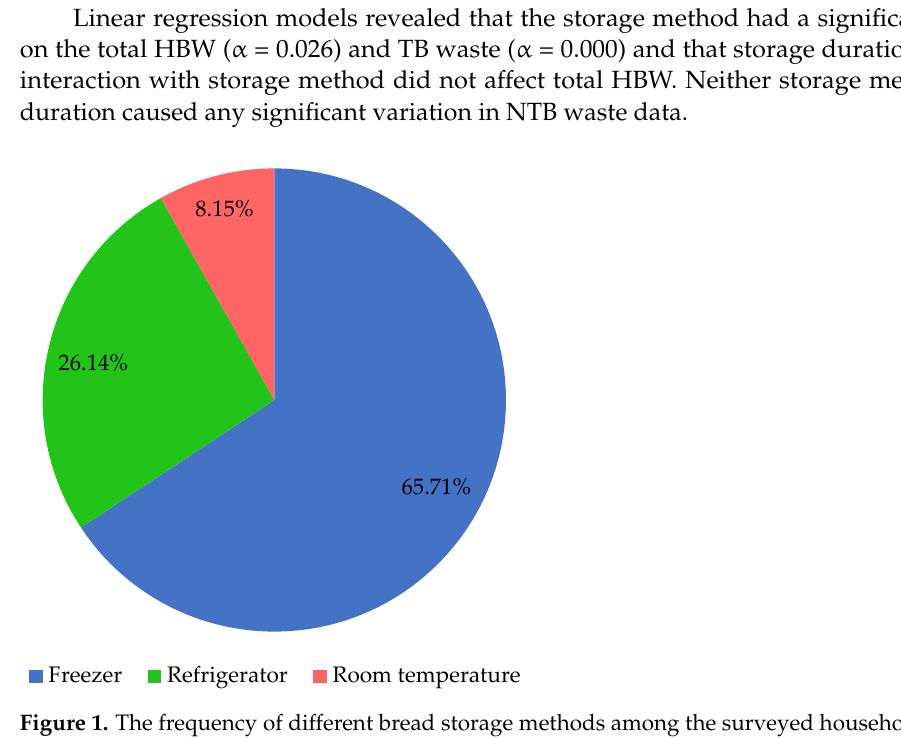
Figure 1. The frequency of different bread storage methods among the surveyed households.